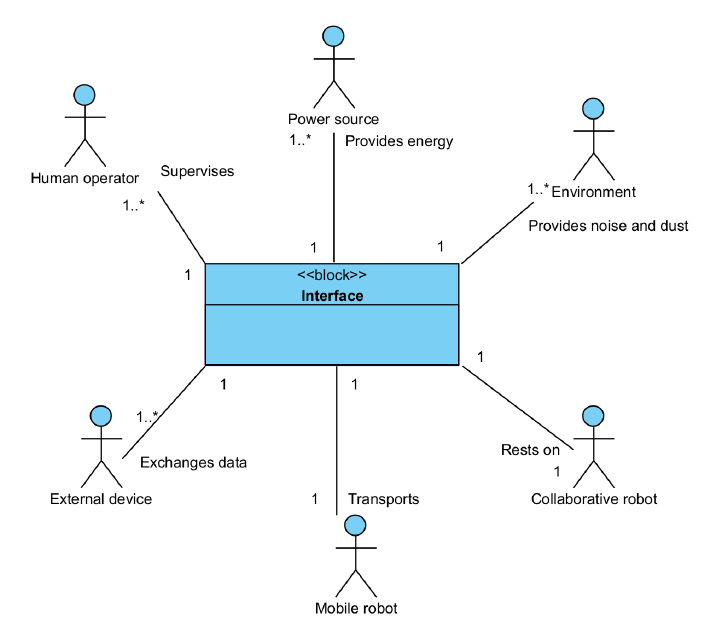
Figure 9. System context and external entities.